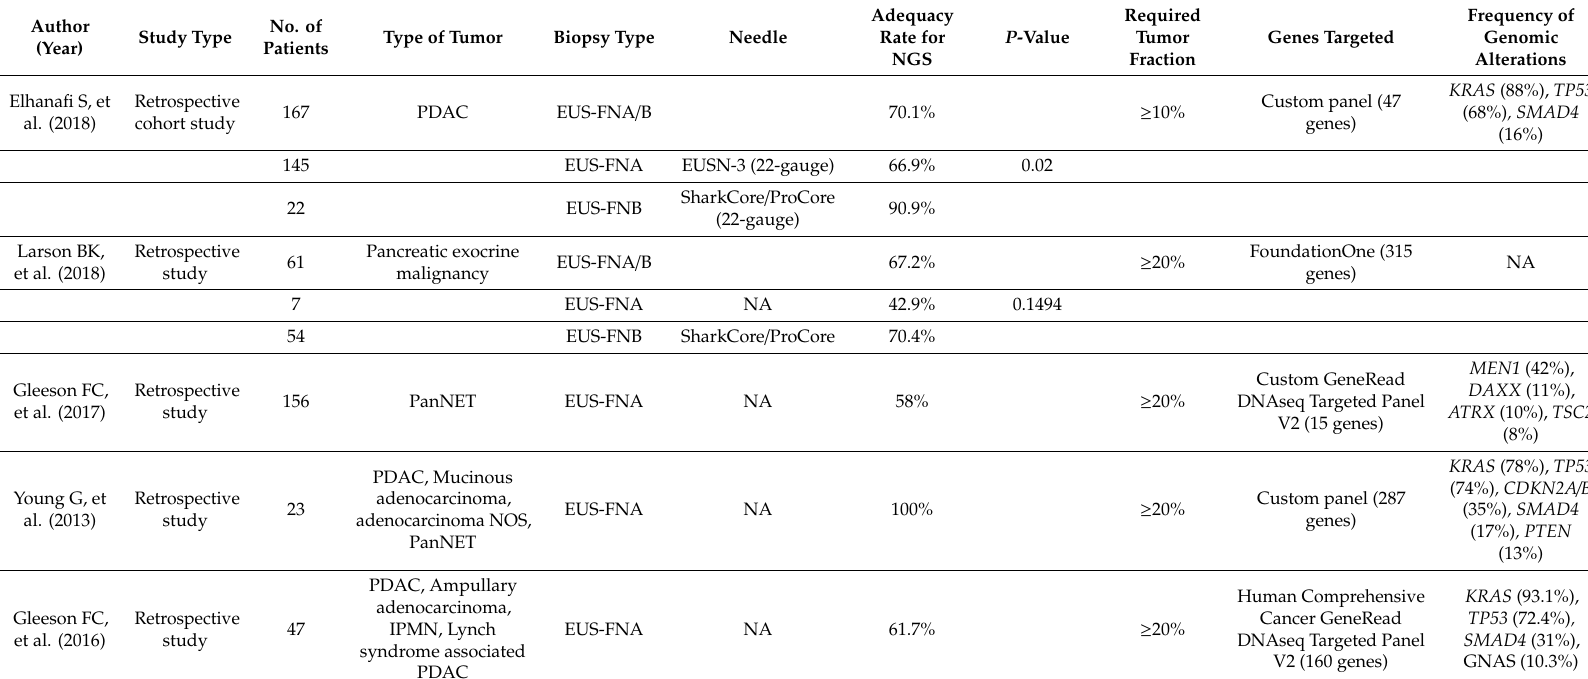
Table 1. Adequacy rate of EUS-TA samples for NGS in pancreatic solid